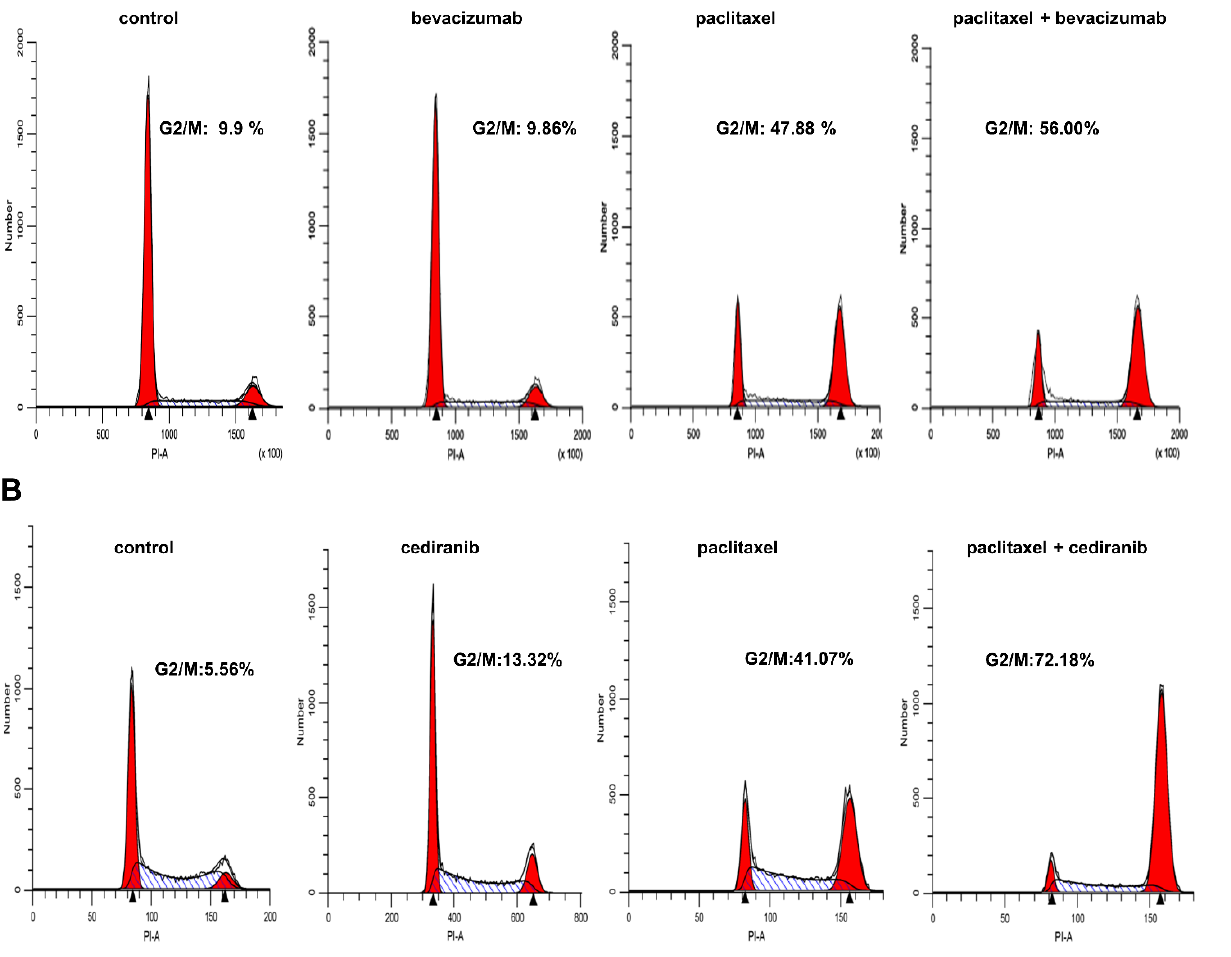
Figure 4. Comparison of the effect of cediranib and bevacizumab on cell cycle distribution in Hec50 cells treated with paclitaxel . ( A ) Cell cycle distribution in Hec50 cells treated with DMSO (Control), 14 nM paclitaxel, 1 µM bevacizumab, or a combination of paclitaxel and 1 µM bevacizumab for 24 h. ( B ) Cell cycle distribution for Hec50 cells treated with vehicle (DMSO), 14 nM paclitaxel, 1 µM cediranib, or a combination of 14 nM paclitaxel and 1 µM cediranib. Insets denote the percentage of cells in the G2/M phase of the cell cycle.